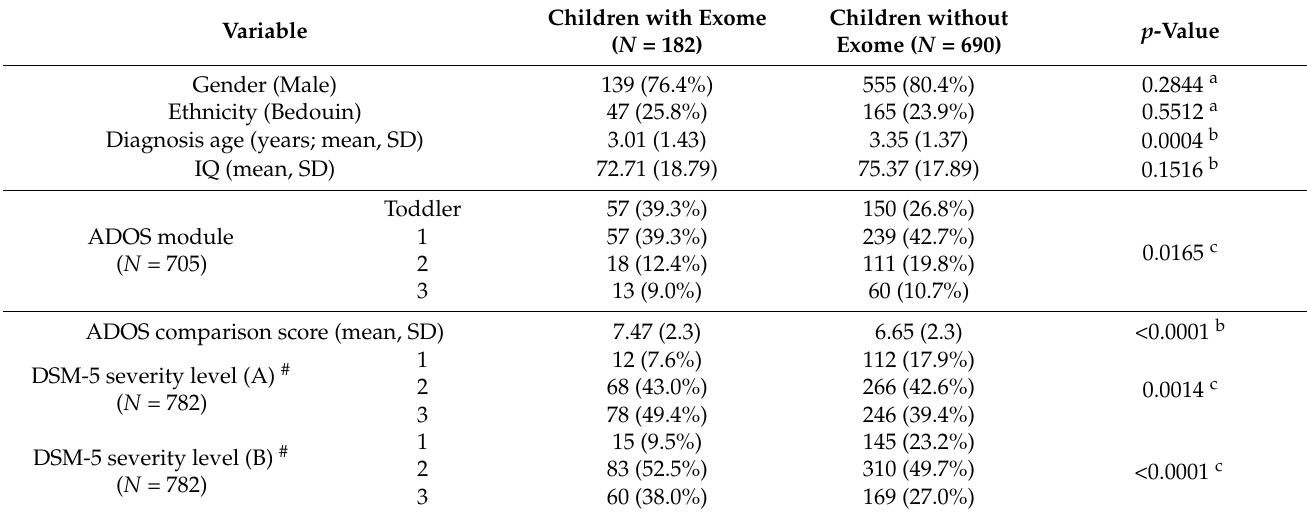
Table 1. Characteristics of the 872 children with ASD in the NARCI